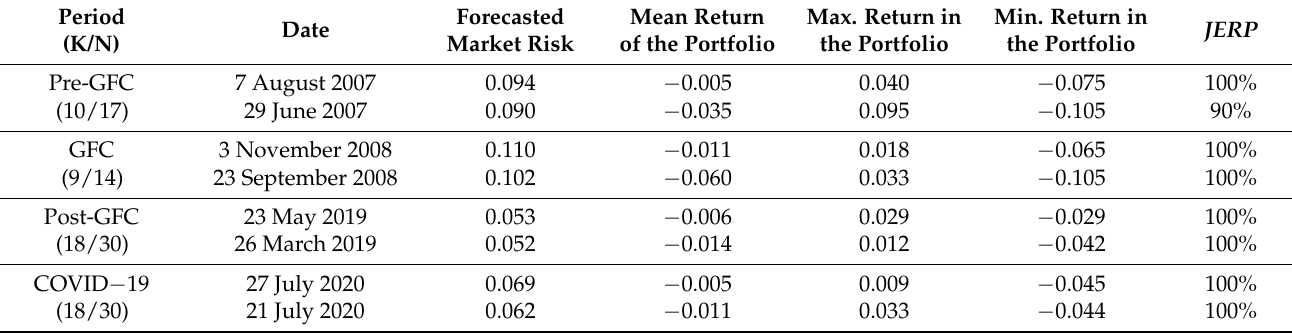
Table 3. Joint extreme risk